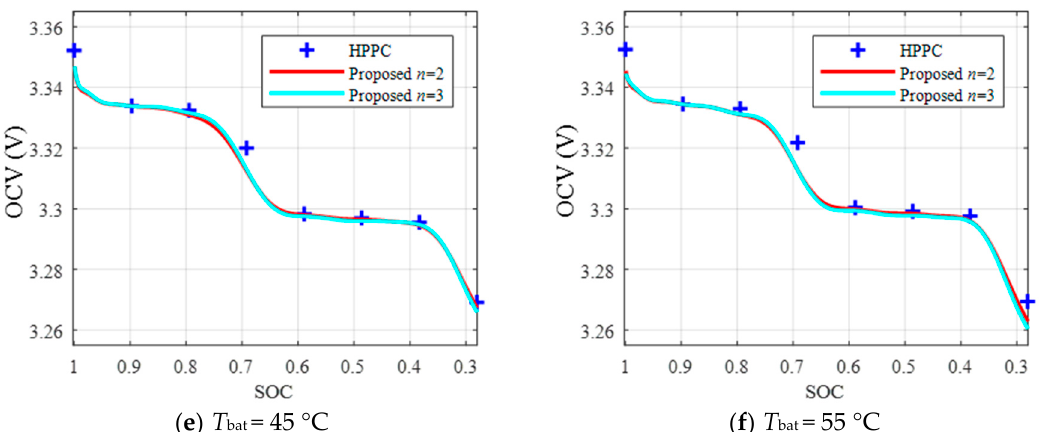
Figure 8. Estimation results of the hybrid pulse power characterization (HPPC) method and the proposed method, with n = 2 and 3, respectively. ( a ) T bat = 5 °C ; ( b ) T bat = 15 °C ; ( c ) T bat = 25 °C ; ( d ) T bat = 35 °C ; ( e ) T bat = 45 °C ; ( f ) T bat = 55 °C.